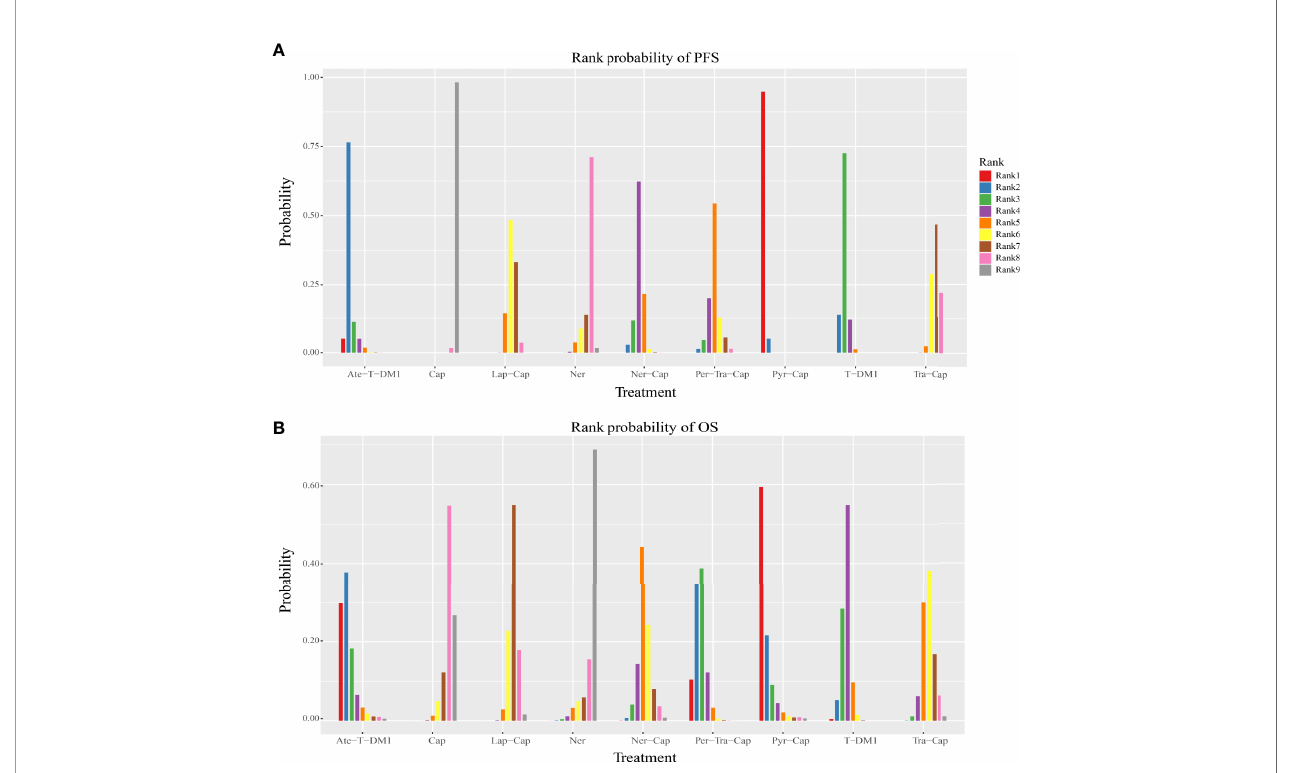
FIGURE 5 | Rank probability plot of (A) PFS and (B) OS. PFS, progression-free survival; OS, overall survival; T-DM1, trastuzumab emtansine; Lap, lapatinib; Tra, trastuzumab; Cap, capecitabine; Ner, neratinib; Per, pertuzumab; Pyr, pyrotinib; Ate,